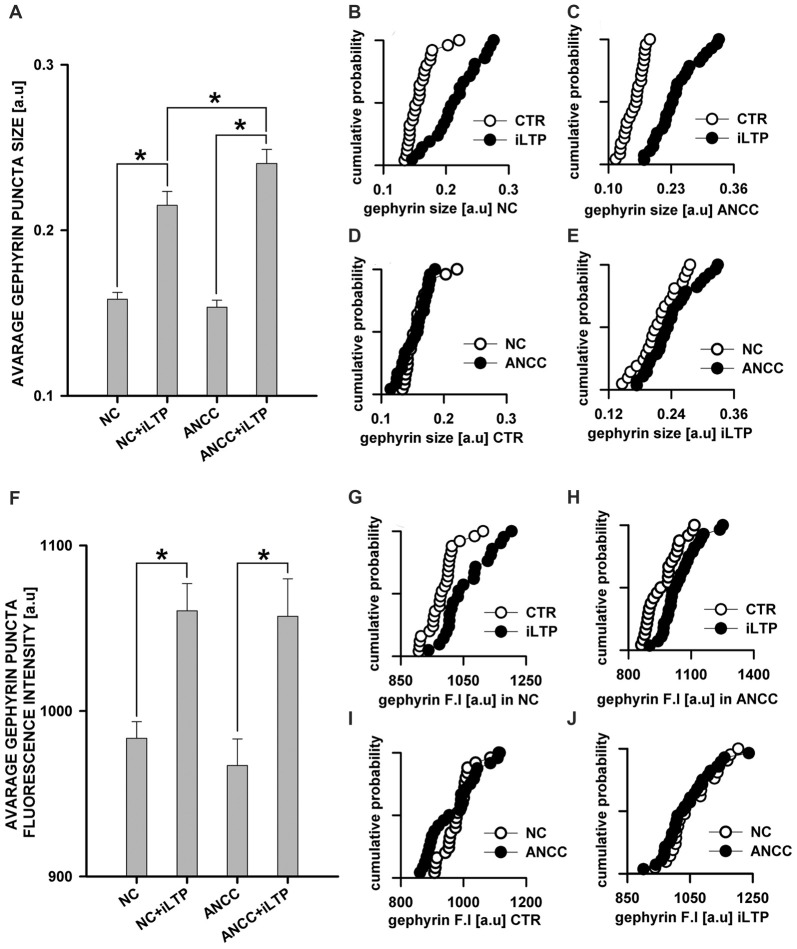
Supplementation of NC with astrocytes strongly upregulate morphological changes introduced by iLTP. (A) Comparison of average gephyrin puncta size in NC and ANCC with or without iLTP induction. Cumulative representation of gephyrin size in (B) NC with and without iLTP induction, (C) ANCC with and without iLTP induction, (D) NC and ANCC without stimulation, (E) NC and ANCC with iLTP induction. (F) Comparison of average gephyrin puncta fluorescence intensity in NC and ANCC with or without iLTP induction. Cumulative representation of gephyrin fluorescence intensity in (G) NC with and without iLTP induction, (H) ANCC with and without iLTP induction, (I) NC and ANCC without stimulation, (J) NC and ANCC with stimulation. Statistical significant results in bar charts (p < 0.05) are represented with star mark.